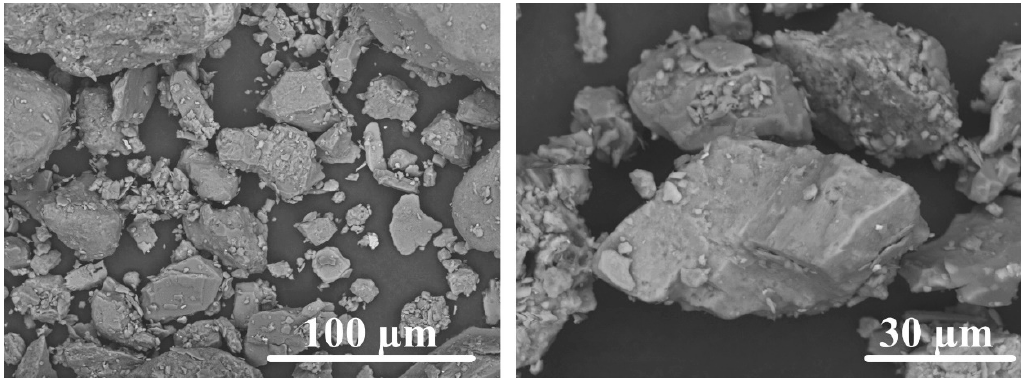
Figure 6. Angular silty particles from Ahb horizon of paleosol 1 with signs of cryogenic